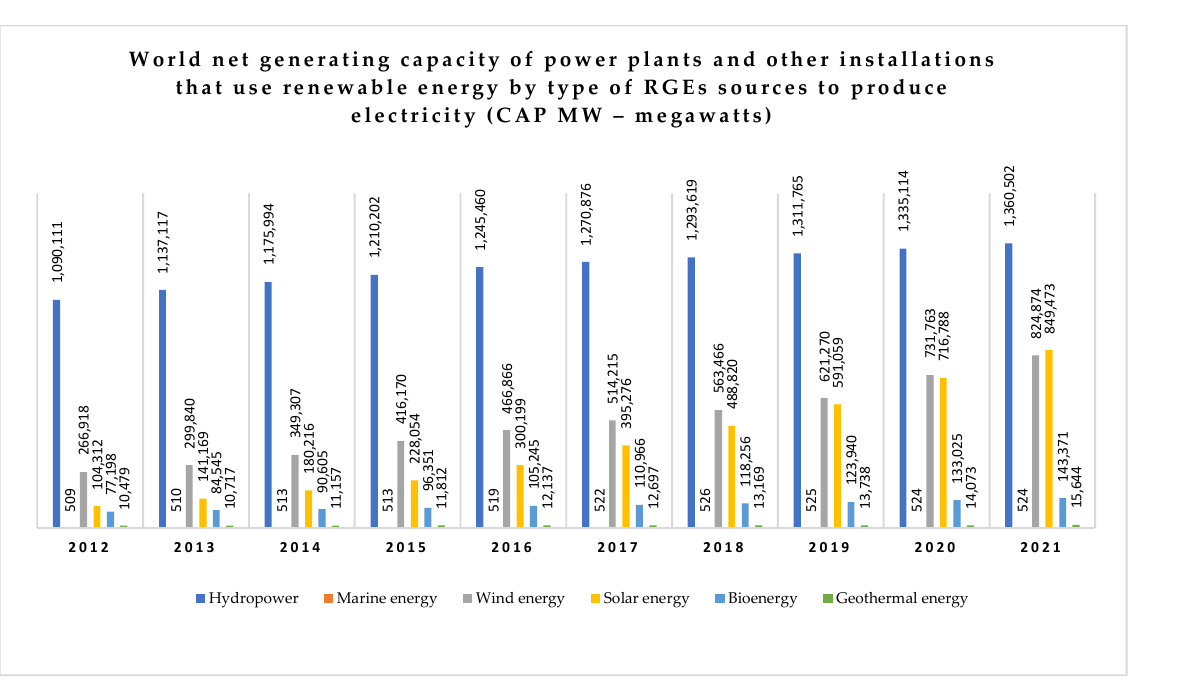
Figure 2. The world net generating capacity of power stations and other facilities that generate electricity using renewable energy sources by type of RGEs (CAP), 2012–2021. Source: the authors centralized and adapted data published by ref. [177].